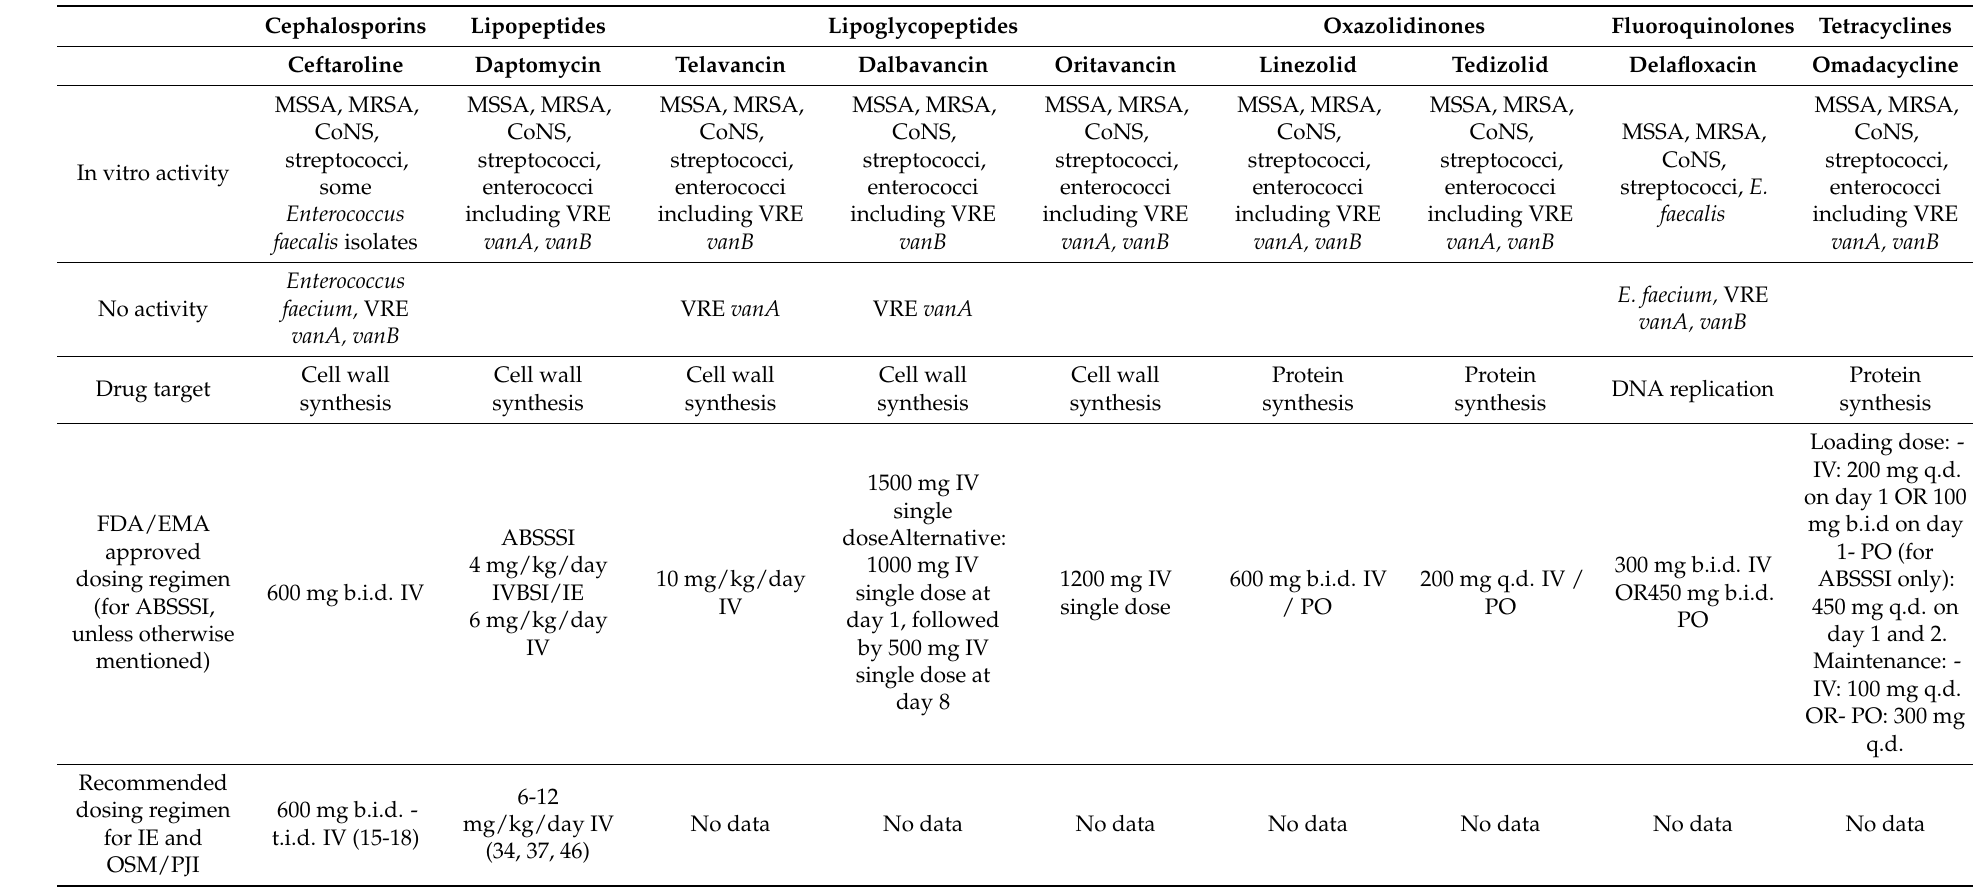
Table 1. General features of nine Food and Drug Administration (FDA)- or European Medicines Agency (EMA)- approved antibiotic drugs with Gram-positive activity discussed in this